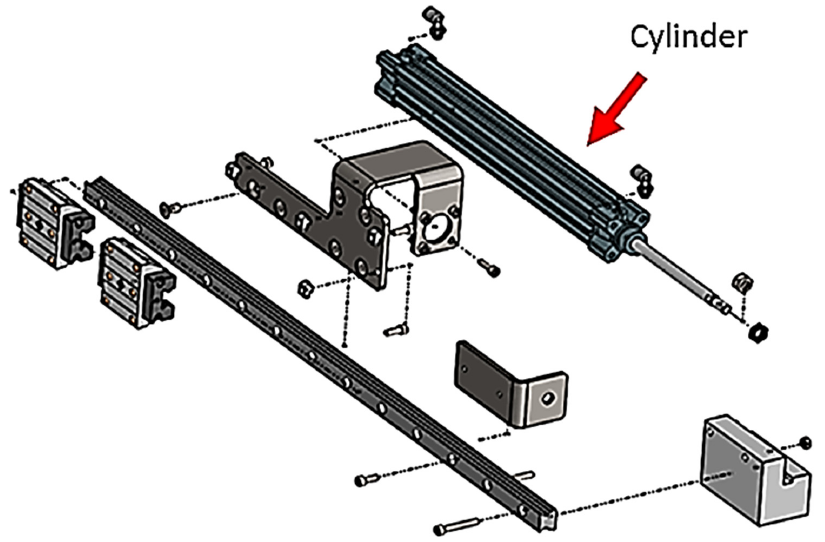
Figure 20. Cradle alignment kit’s exploded view.